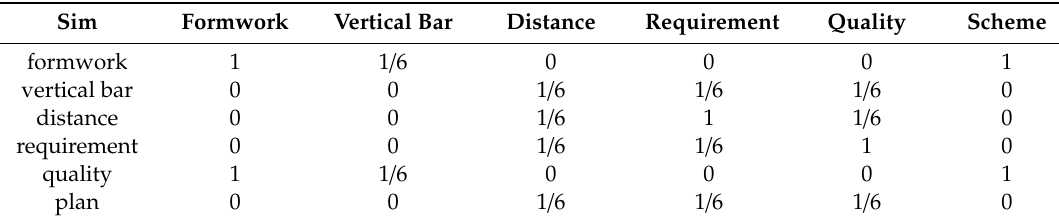
Table 6. Similarity of nouns between N 0 and N 1 .